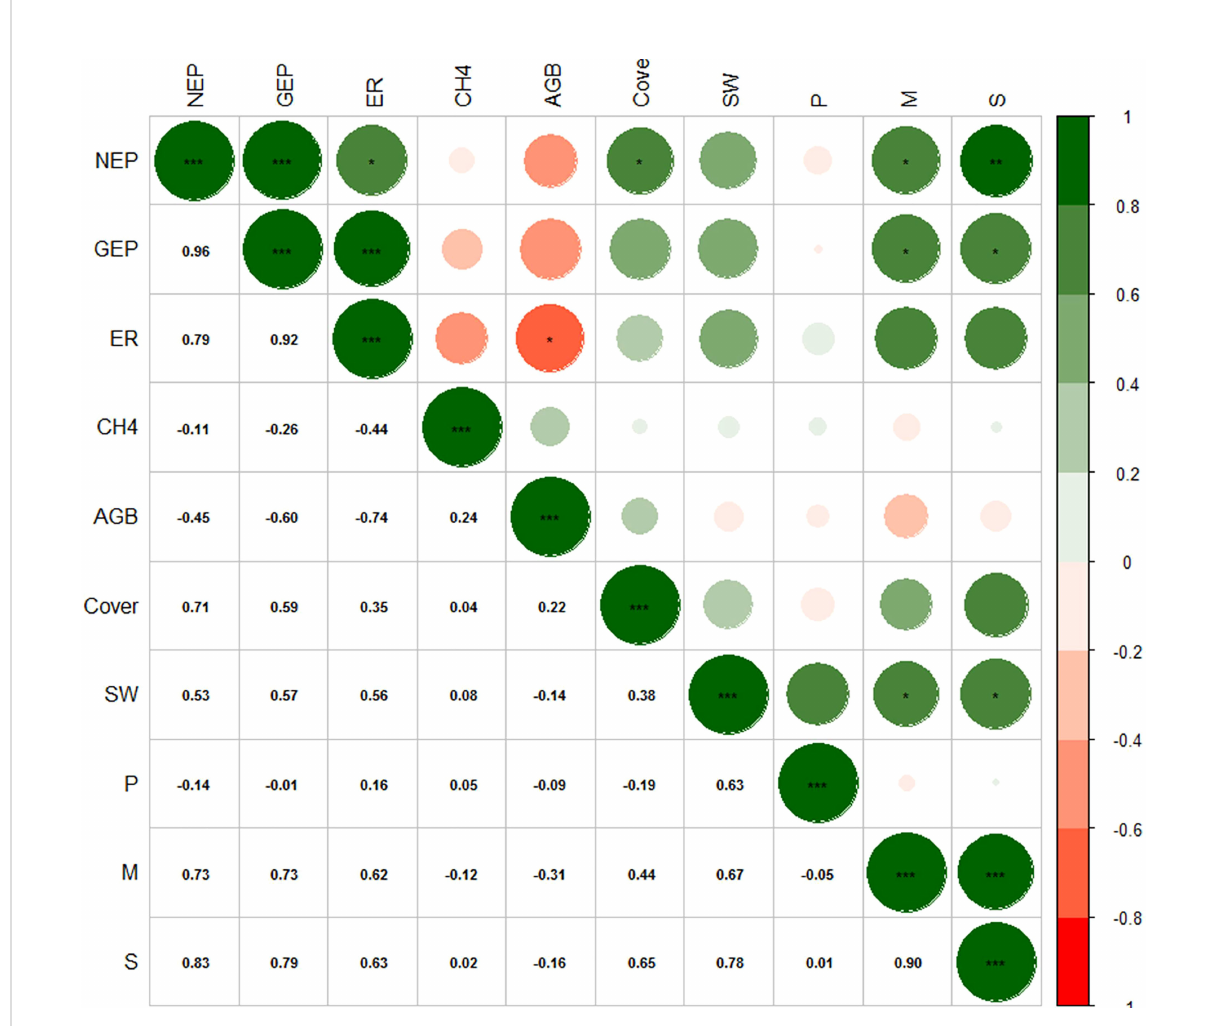
FIGURE 7 Heat map of the correlations between the vegetation characteristics and carbon fl uxes. A green circle indicates that the correlation coef fi cient was positive and a red circle indicates that the correlation coef fi cient was negative. The larger the diameter of the circle, the higher the absolute value of the correlation coef fi cient. NEP: net ecosystem production, GEP: gross ecosystem production, ER: ecosystem respiration, CH 4 : methane fl uxes, AGB: aboveground biomass, Cover: vegetation coverage, SW: Shannon-wiener index, P: Pielou index, M: Margalef index, S: number of species; “ *** ” , “ ** ” and “ * ” represent signi fi cant relationship of P < 0.001, P < 0.01 and P < 0.05,